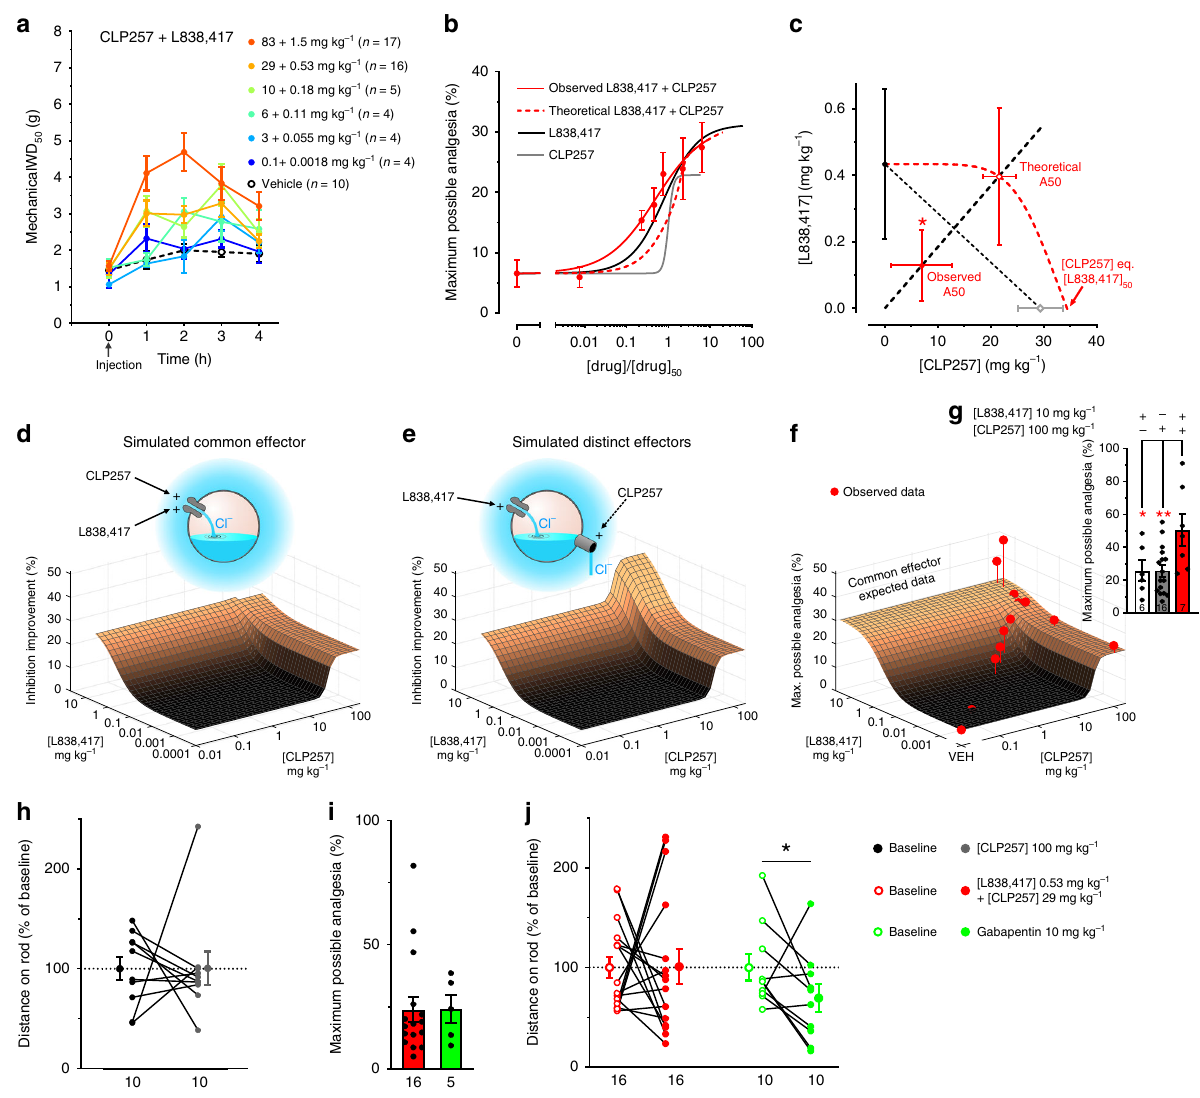
Fig. 6 Synergistic analgesic action of L838,417 and CLP257. a Partial reversal of mechanical allodynia produced by L838,417 and CLP257 co-injected at a fi xed dose ratio [1:55] in 14-28 day post-surgery PNI rats. b Normalized dose-response curve of L838,417 (black line), CLP257 (gray line), expected L838,417 + CLP257 (dashed red line) and observed L838,417 + CLP257 (red line) at different proportions of their EC50s (see methods and Fig. 4). c Isobologram of the fi ts obtained in Fig. 6b. d , e Surface plots of computer simulated analgesic effect of co-administration of L838,417 and CLP257 when they act on a common effector (Fig. 6d and Eq. 10) or when they target two distinct mechanisms (inhibitory conductance and KCC2 activity) (Fig. 6e and Eq. 11). f 3D plot of the pharmacological synergism between L838,417 and CLP257. Copper-colored surface represents the theoretical analgesia calculated from the respective L838,417 and CLP257 dose-response curves using equivalent dose under the common effector assumption. The experimentally obtained maximum possible analgesia (MPA) for each dose combination tested in PNI animals is indicated by red dots. g Over-additive effect of the combined doses of 10 mg kg − 1 of L838,417 with 100 mg kg − 1 of CLP257 compared to a single dose of L838,417 or CLP257 or to the expected analgesic effect (MPA ≈ 30%) of the two-drug combination presented in Fig. 6f. h Maximum distance on rod of CLP257 at 100 mg kg − 1 2 h after i.p. injection. i Identical MPA over 4 h for a combination of L838,417 (0.53 mg kg − 1 ) with CLP257 (29 mg kg -1 ) vs. Gabapentin (10 mg kg -1 ). j Rotarod testing Maximum distance run with the same drugs as in i , 2 h after i.p. injection. (* P < 0.05; ** P < 0.01). Source data is available as a Source Data fi